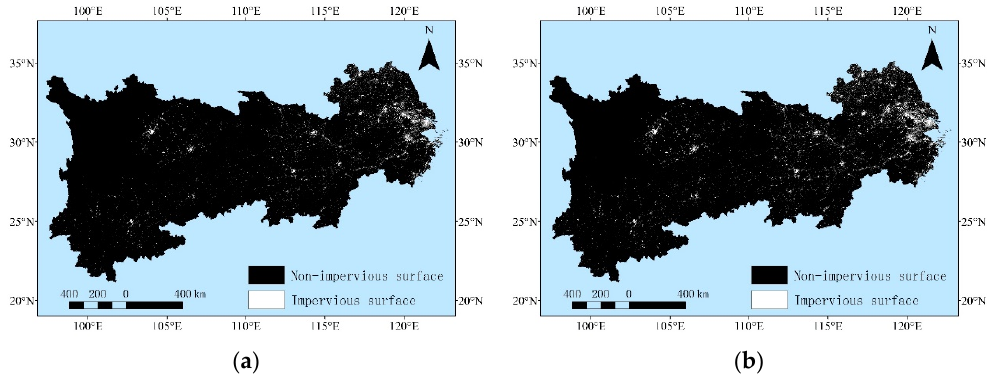
Figure 3. The impervious surface maps for YREB: ( a ) 2012; ( b ) 2019.